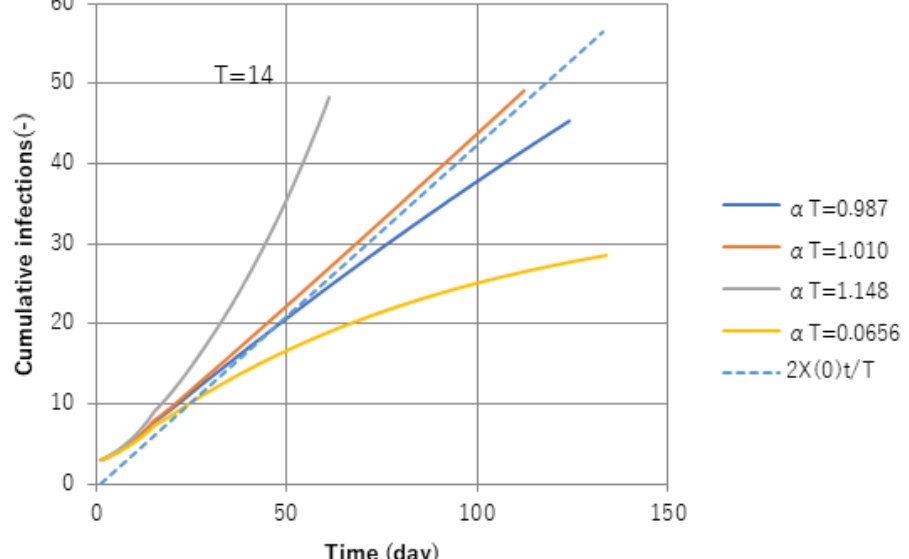
Figure 2. Behavior of solution x with a change in the value of the parameter ( α T ). A clear change in the behavior of the solution x(t) depending on the value of α T , a so-called bifurcation nature, is apparent. In fact, α T =1 is found to be a threshold with α T >1 causing an outbreak and α T <1 an endemic. This is consistent with the interpretation that α T is equal to R 0 in equation